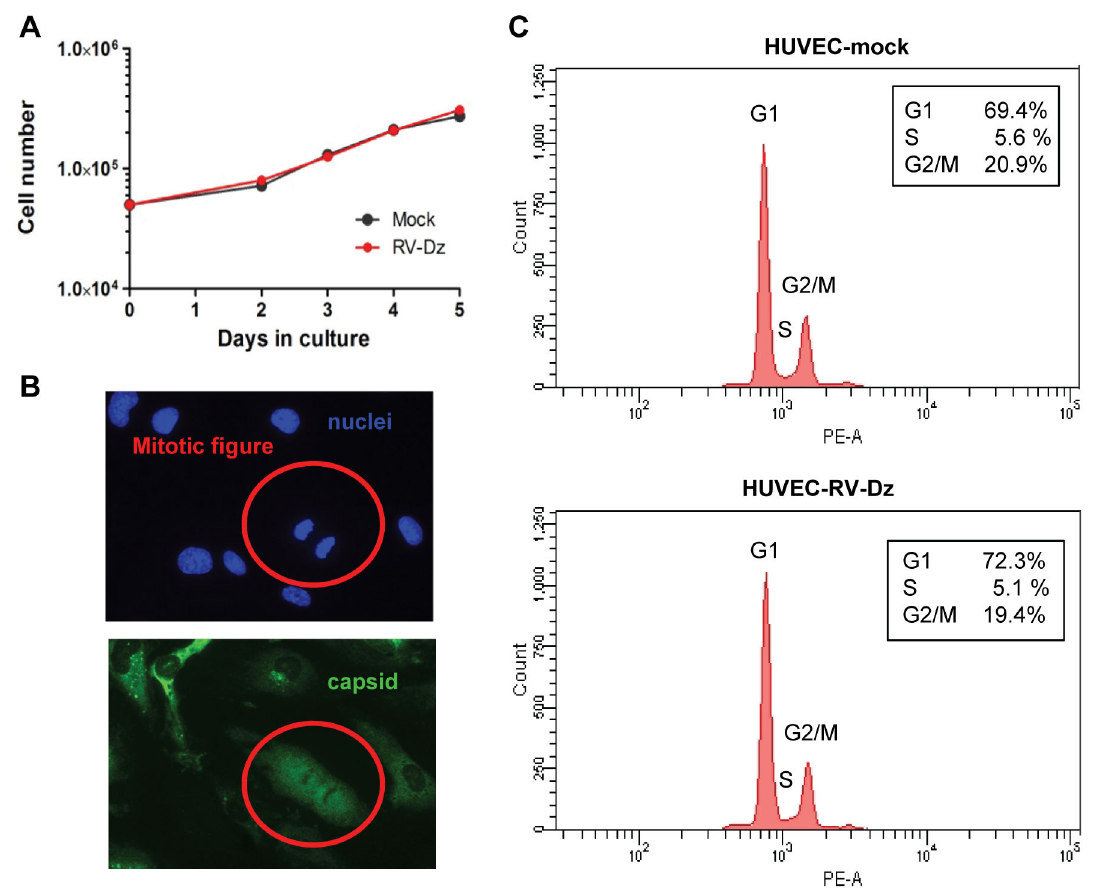
Figure 4. Effects of RV infection on cell proliferation and mitosis. ( A ) Growth curves of mock-infected and RV-infected HUVECs. HUVEC were mock infected or infected with RV-Dz at MOI=10 and then counted daily. The data are results of 2 independent experiments each performed in duplicate. ( B ) Mitosis in infected HUVEC. At 2 dpi the mock infected and infected HUVEC (RV-Dz, MOI=10) were immunostained by IFA with capsid MAb and DAPI to quantitate infected cells and mitotic figures. Mitotic indexes (MI) were calculated as % cells with mitotic figures in two duplicate wells. Note RV-antigen positive mitotic cell in red circle. ( C ) Cell cycle analysis of infected HUVEC. Serum-starved HUVECs were mock-infected or infected with RV-Dz at MOI=10. Histograms of cell cycle analysis at 1 dpi show DNA content of propidium iodide-stained cells by flow cytometry and % of cells in each phase of the cell cycle. The representative results of two independent experiments are